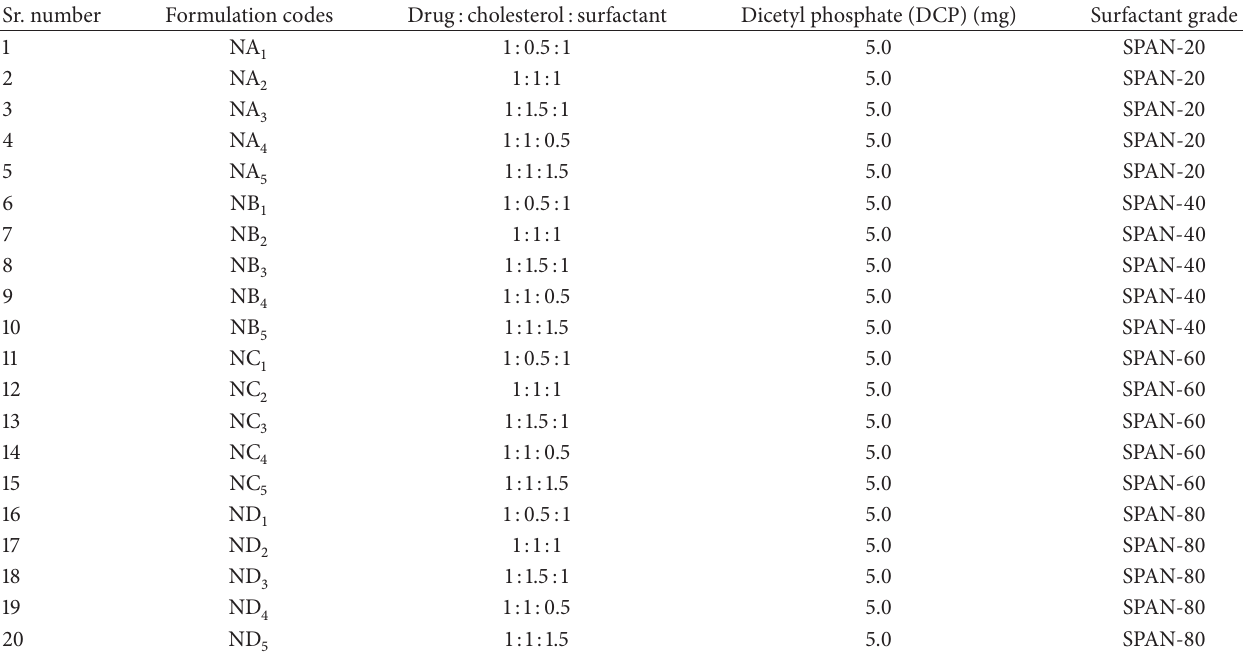
Table 1: Composition of empty niosomal formulations at various ratios of cholesterol : surfactant. Sr.